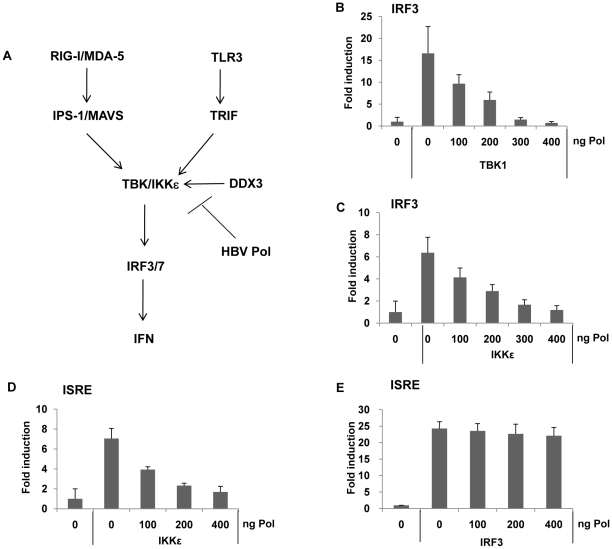
HBV Pol blocks IRF activation by inhibiting TBK1/IKKε activity.(A) Schematic of IRF signaling pathway leading to IFN production. TBK1 serves as a central effector kinase, but TBK1 function is also shared by the highly related IKKε kinase in some cells. DDX3 is described in an experiment shown in Fig. 6 (see text). (B and C) HepG2 cells were cotransfected with an incremental amount of HBV Pol expression construct to determine the effect of HBV Pol on IRF3 signaling. To induce IRF3 signaling, or TBK1 (B) or IKKε (C) expression constructs were transfected. IRF3 activation was monitored as shown in Fig. 4. (D and E) Cells are transfected as in (B and C), respectively, except that ISRE-luciferase reporter construct was transfected, instead of the IRF reporter construct.